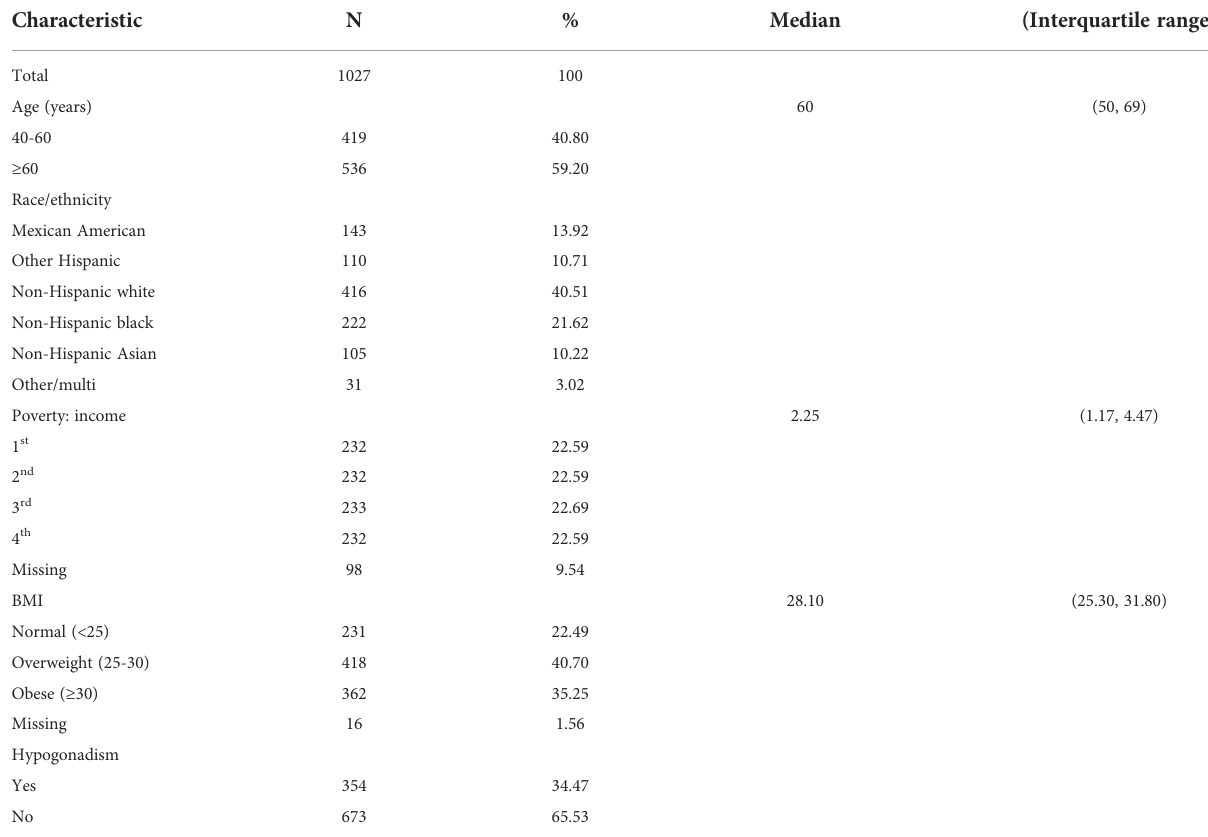
TABLE 1 Characteristics of study population, NHANES